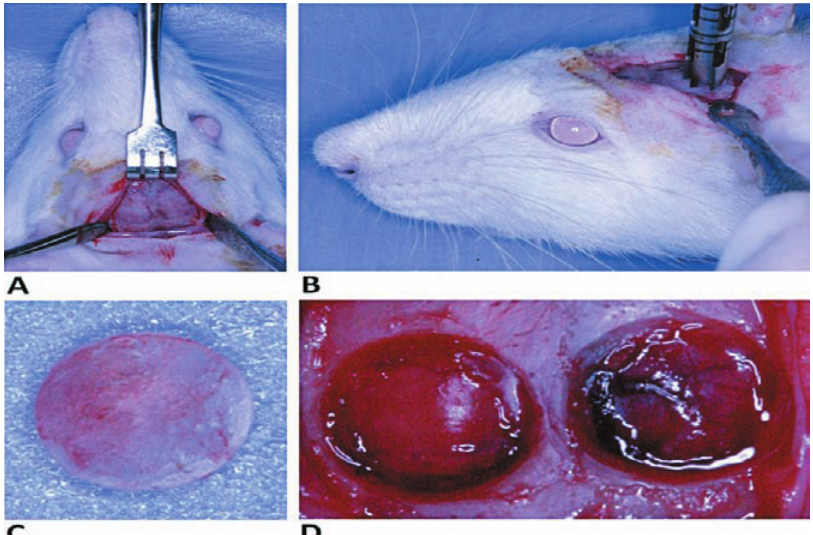
Figure 2- Surgical procedure. A) Surgical access. A linear incision in an anterior-posterior direction was made in the median region of calvaria and the dermoperiostic was detached. B) Trephine bur used to prepare the bone defects. C) The bone block removed from the left side was positioned in the right side defect. D) An approximate view of the defects to be filled